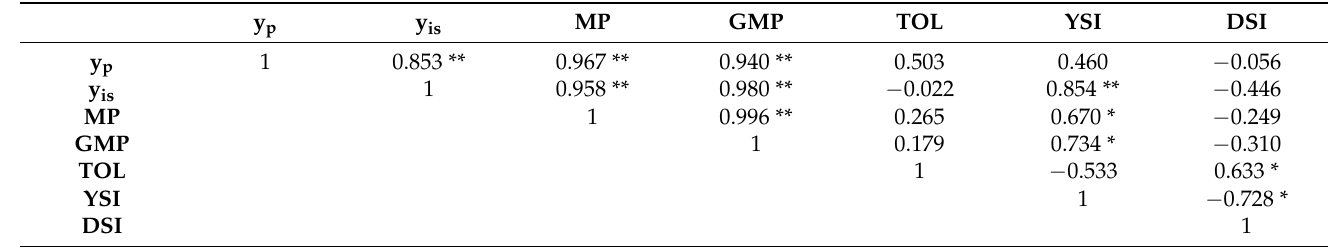
Table 6. Correlation of yield under 100% FC and 50% FC conditions with each of mean productivity (MP), geometric mean productivity (GMP), tolerance index (TOL), drought susceptibility index (DSI), and yield stability index (YSI). * Correlation is significant at the 0.05 level. ** Correlation is significant at the 0.01